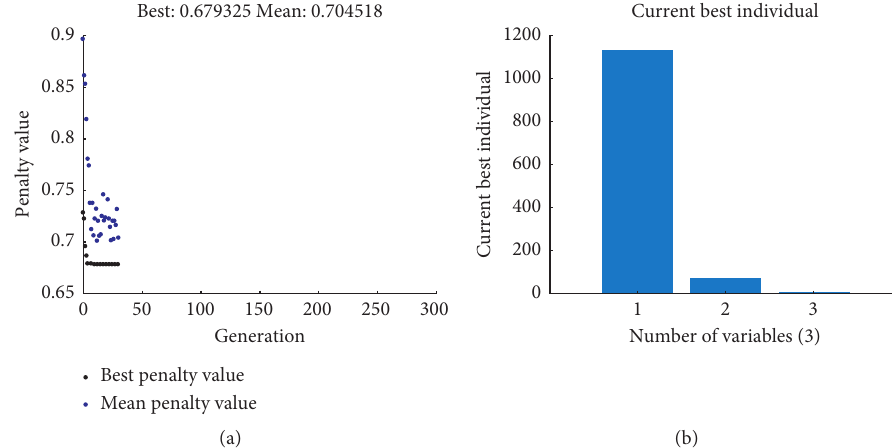
Figure 9: The operation process of GA in MATLAB R2014a. (a) The change of the best fitness value and the mean penalty value during the operation. (b) The vector value of the best fitness individual in each generation.